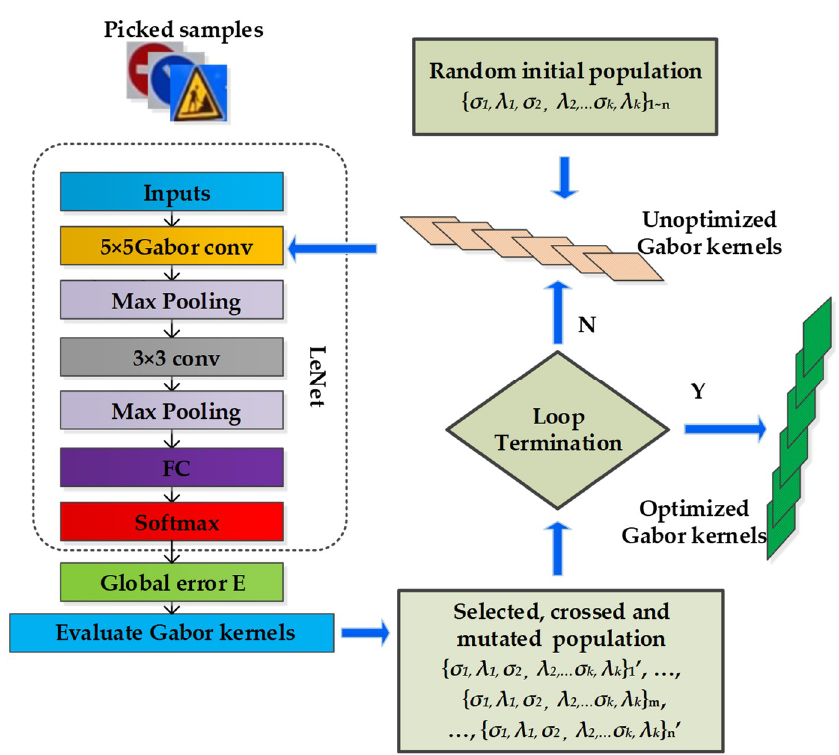
Figure 6. Flow chart of multipopulation genetic algorithm (MPGA) optimization for Gabor convolutional kernels. Individual { σ 1 , λ 1 , σ 2 , λ 2 , · · · , σ k , λ k } represents a combination of Gabor kernels in the convolutional layer. The individual { σ 1 , λ 1 , σ 2 , λ 2 , · · · , σ k , λ k } is the optional individual selected from the previous generation.